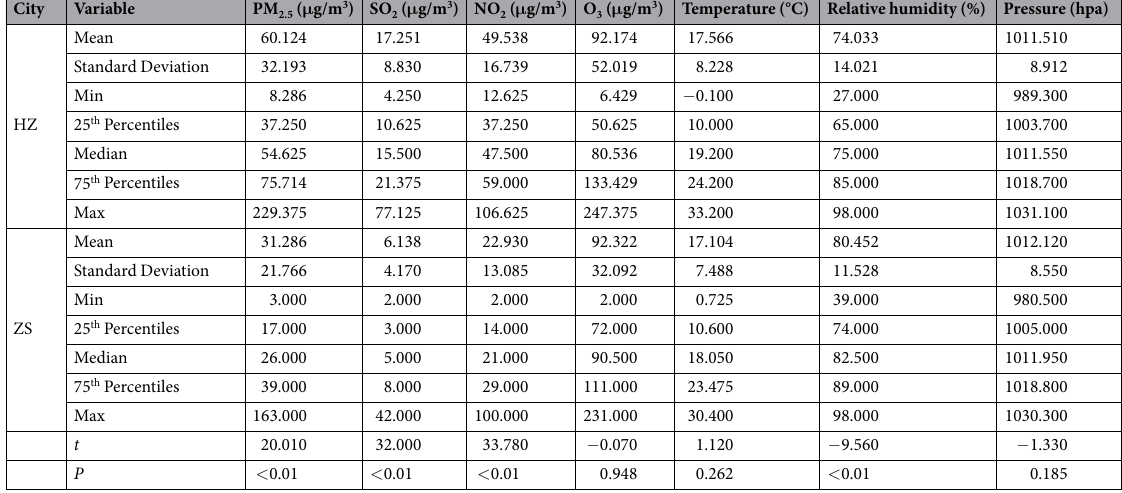
Table 1. Summary statistics of air pollutants and meteorological factors in both city from